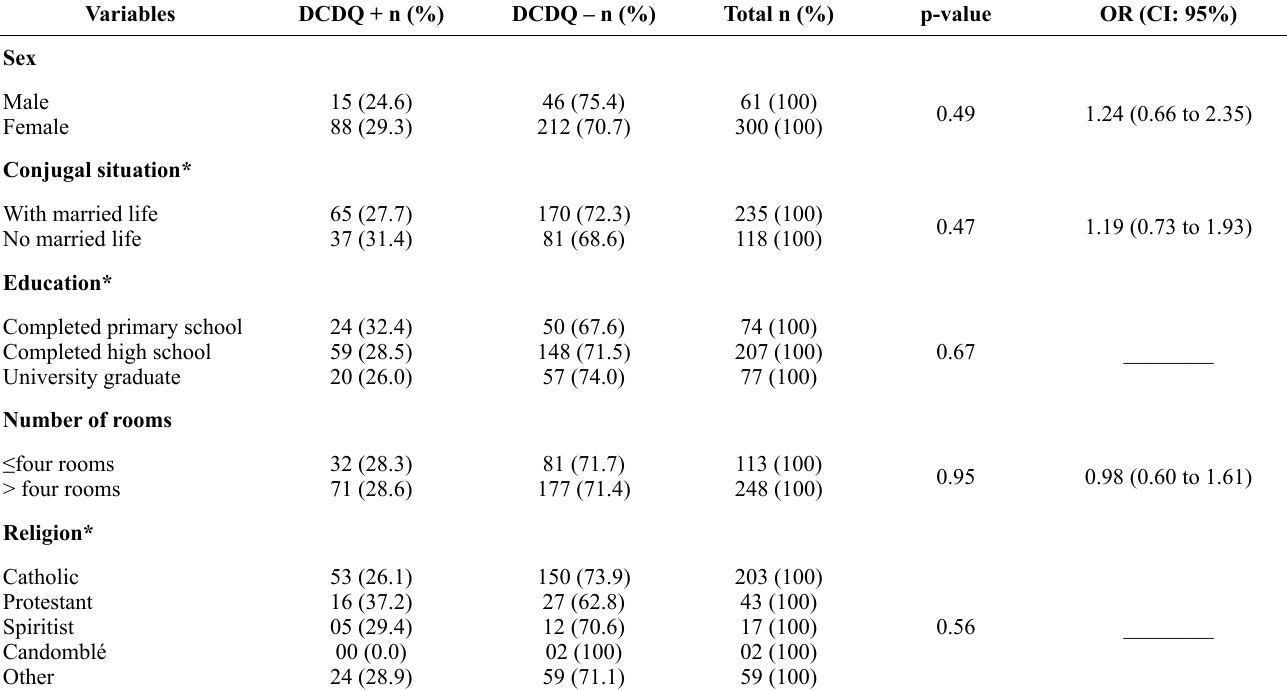
Table 1 – Parents/guardians socio-demographic factors between children classified as DCDQ positive (DCDQ+) and DCDQ negative (DCDQ